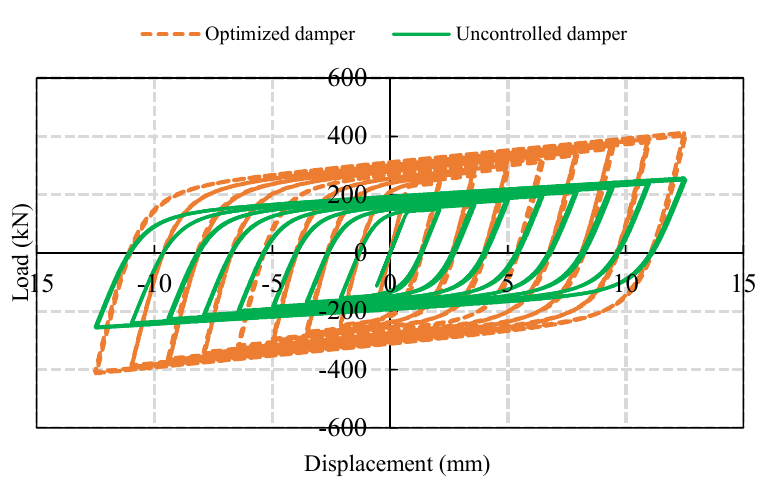
Figure 10. Hysteretic behavior comparison of the optimized dampers and initial models.